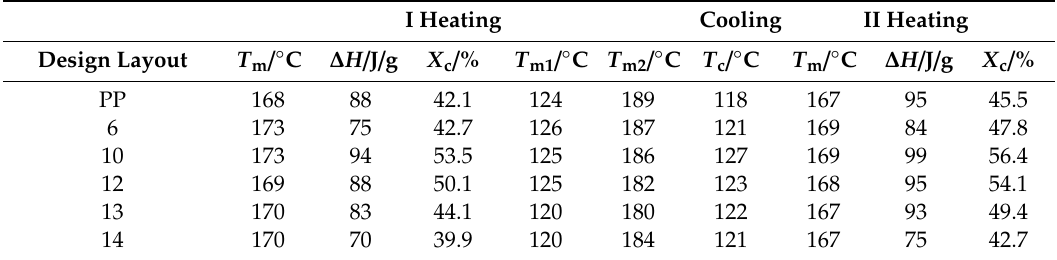
Table 5. Results of DSC measurements of melting temperature, melting enthalpy and degree of crystallinity of the initial PP and samples of the extrudate obtained according to the experimental design layouts (Table 1). I Heating Cooling II Heating